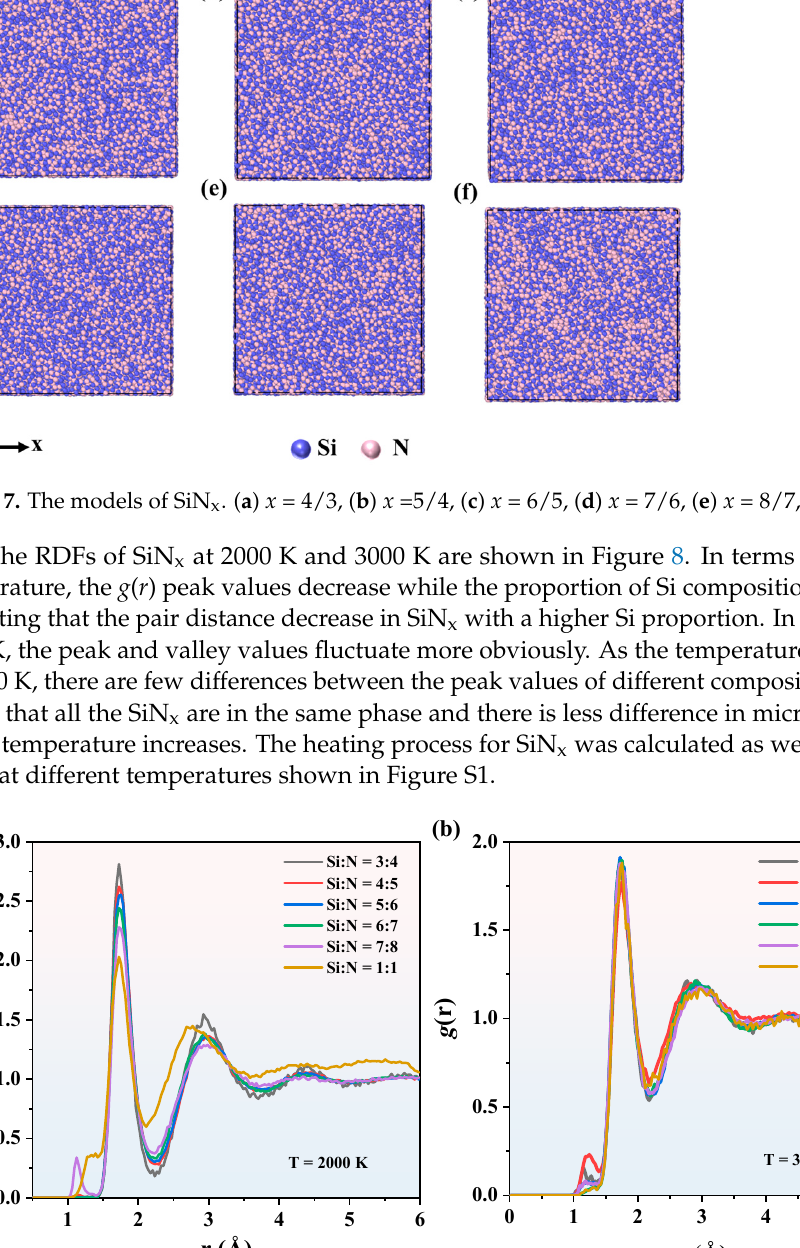
(b) Figure 6. The BADs comparison of Si 3 N 4 between NNP + MD and AIMD at 3000 K. ( a ) the N-Si-N BADs, ( b ) the Si-N-Si BADs. 3.2. The NPP Applied for Structure Information Similar to the empirical potentials, the NNP can also be used for different composi- tions with the same elements. To study the effect of compositions on SiN